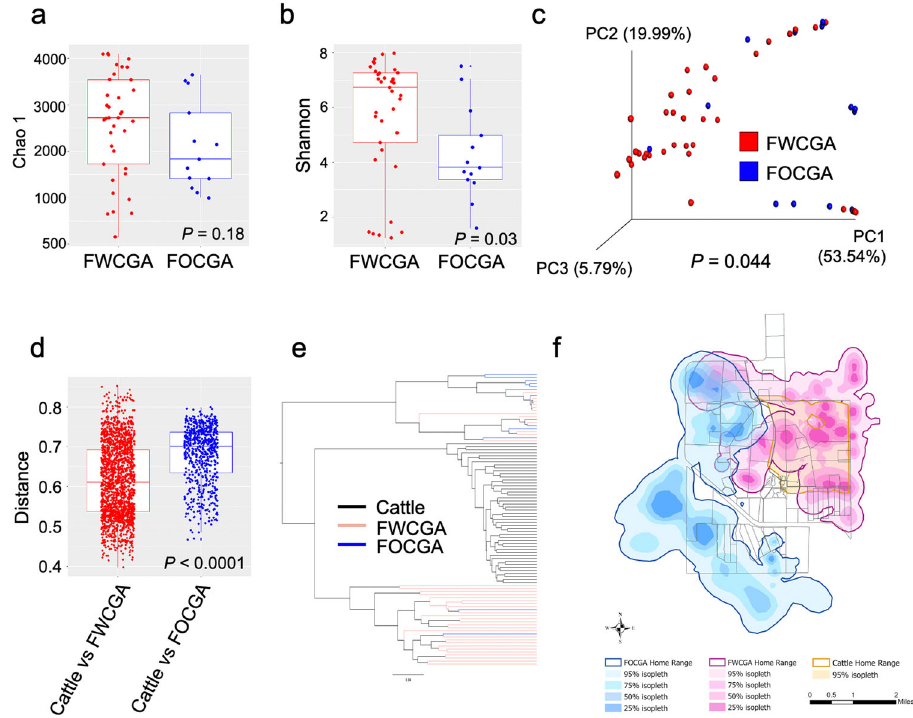
Fig. 4 Comparison of the microbiota structure between cattle and feral swine groups. Bacterial richness ( a ) and diversity ( b ) of FWCGA and FOCGA. c The PCoA plot derived from weighted UniFrac distances. d The boxplot represents a comparison of weighted UniFrac distances between cattle vs. FWCGA and cattle vs. FOCGA, respectively. e Unweighted Pair Group Method with Arithmetic (UPGMA) tree based on weighted UniFrac distances shows the relatedness of microbiota between individual hosts. f Utilization distributions (UDs) and the 95% isopleth of the UDs for cattle ( n = 11), FWCGA ( n = 22), and FOCGA ( n = 5) from April to May in 2017. Box plots display the median (center line), 25th and 75th percentiles (box) and 5th and 95th percentiles (whiskers) for each individual.